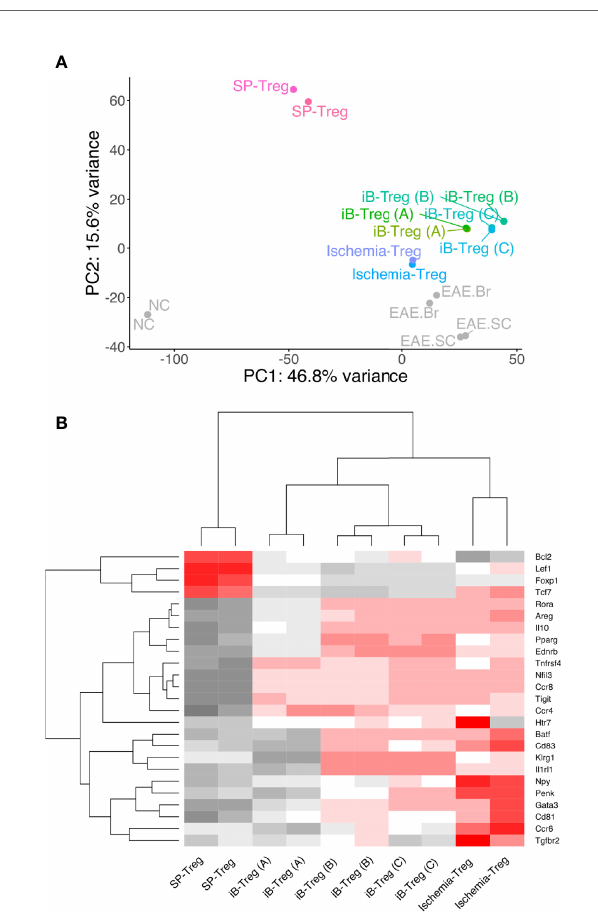
FIGURE 3 | Comparison of gene expression between brain Tregs and iB- Tregs. The three iB-Treg (A – C) conditions were described in Figure 2 . Total RNA of Tregs from spleen, ischemic brain, EAE brain or EAE spinal cord (SC), or iB-Tregs after 6 days of co-culture was isolated, and sequenced. (A) PC analysis (SP-Treg, Ischemia-Treg, iB-Treg (A), iB-Treg (B), iB-Treg (C), NC, EAE.Br and EAE.SC). (B) heatmap analysis [SP-Treg, Ischemia-Treg, iB-Treg (A), iB-Treg (B) and iB-Treg (C)] for representative brain Treg